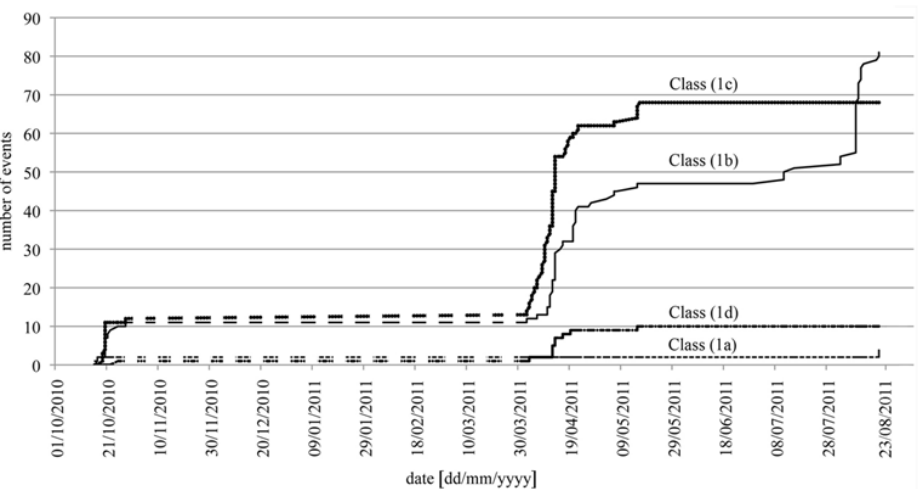
Fig. 8. Cumulative distribution of the number of events characterising each type of single event class. The dashed lines between 1 Novem- ber 2010 and 31 March 2011 represent the no-data